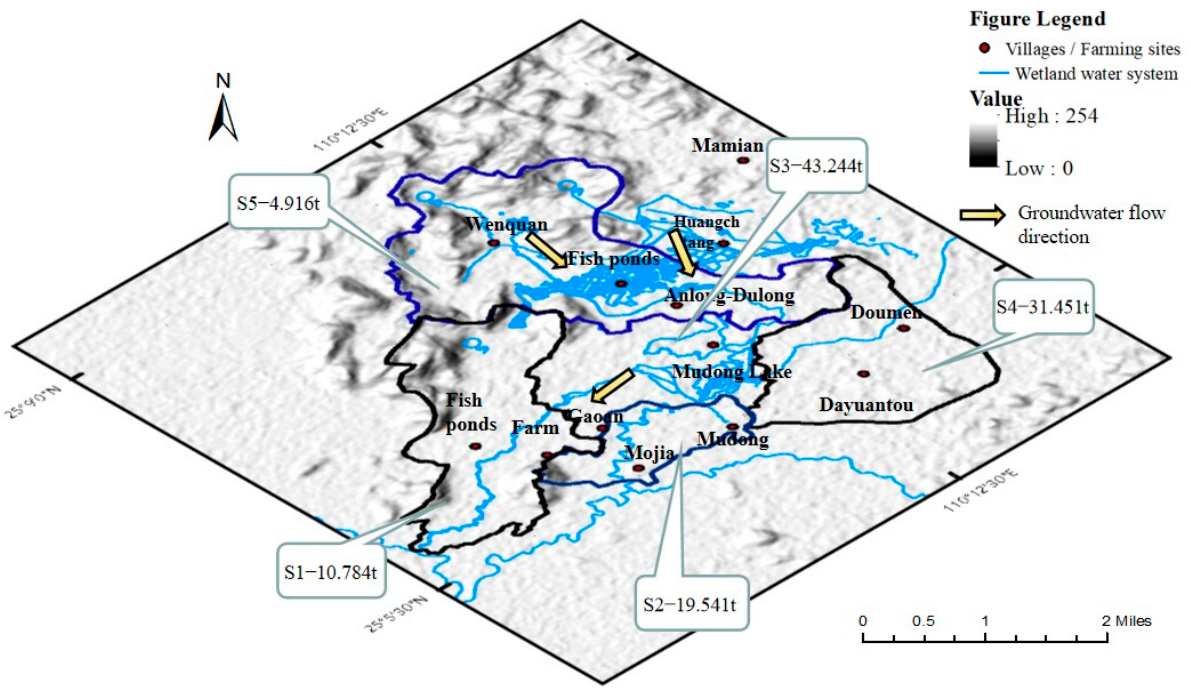
Figure 2. The spatial distribution of monthly average total nitrogen load in the study area in 2019 (unit: